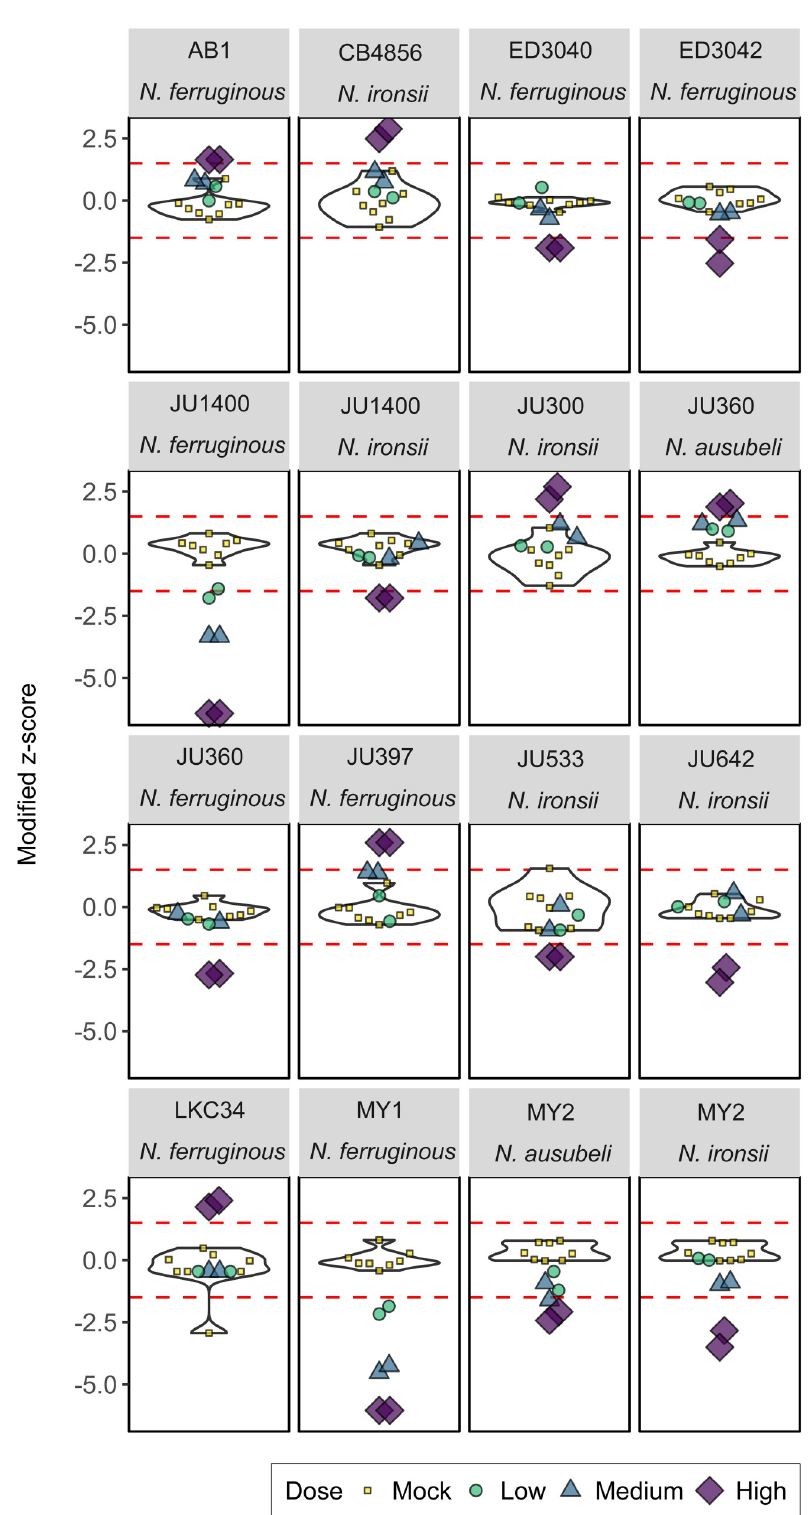
Fig 2. Analysis of PhenoMIP mean fold-change rate identifies 16 candidate nematode/microsporidia interactions. Violin plots of C . elegans wild isolate strains infected by specific microsporidia species. Violins are derived